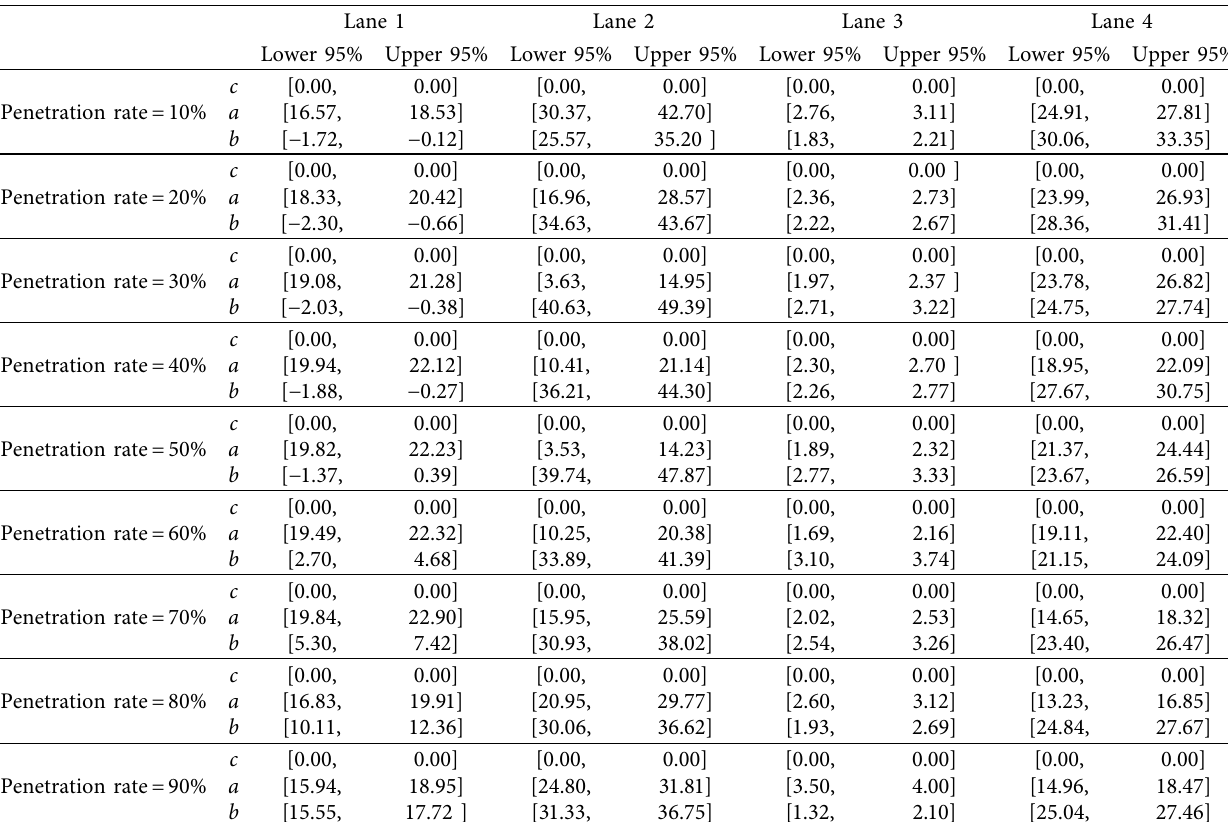
Table 3: The parameter value range of the multiple linear regression model of traffic volume and behaviors of changing lane under different operating ratios of autonomous driving